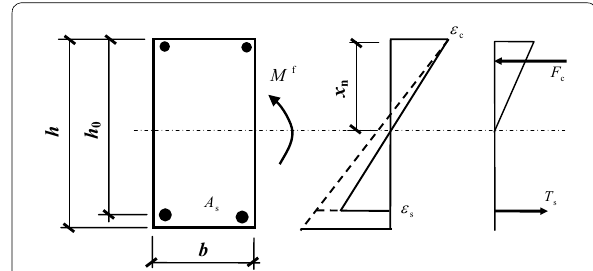
Fig. 7 Cyclic RC beam load and stress and strain